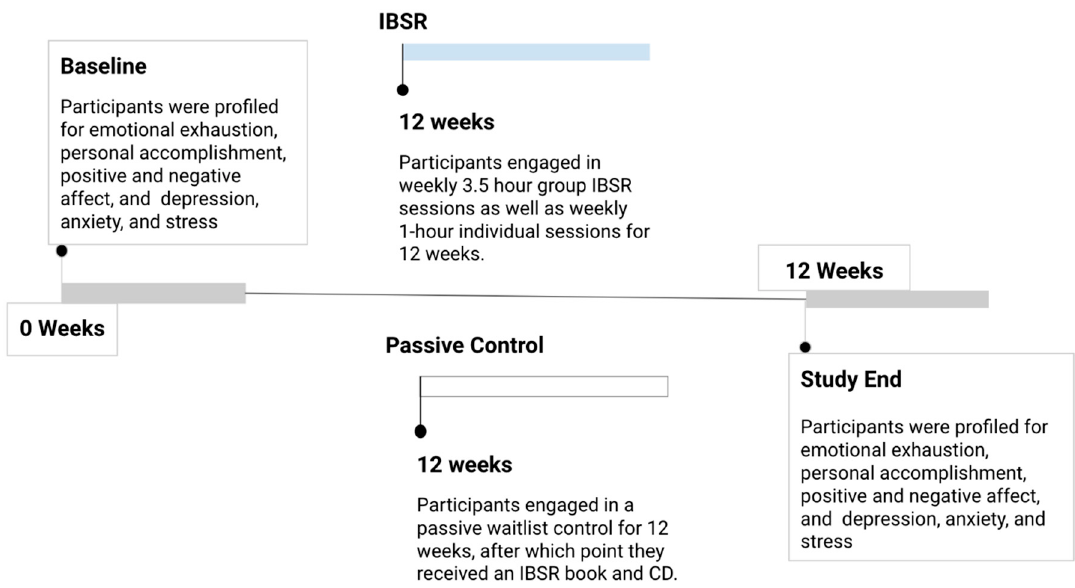
Figure 1. Study timeline. Participants were profiled at baseline for burnout and psychological well- being. They were assigned to Inquiry Based Stress Reduction (IBSR) or control and underwent either a 12-week IBSR training program or a 12-week waiting period. Psychological profiling and assessment of burnout was performed again at study week